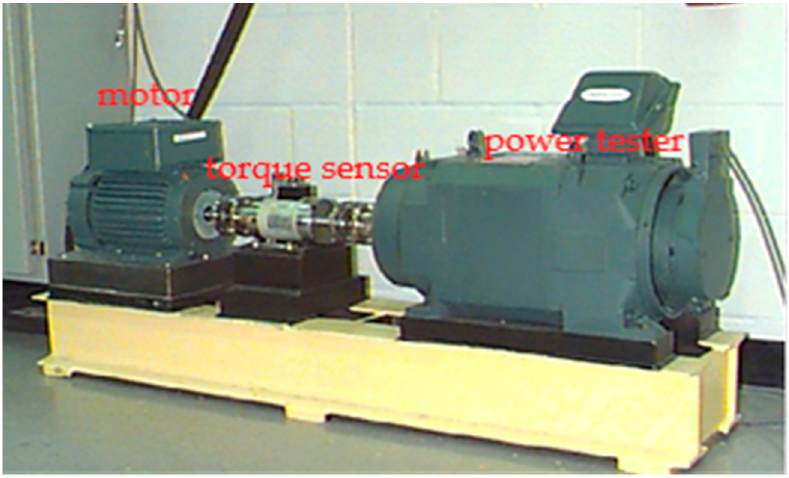
Figure 5. Rolling bearing test platform (Case Western Reserve University (CWRU)).